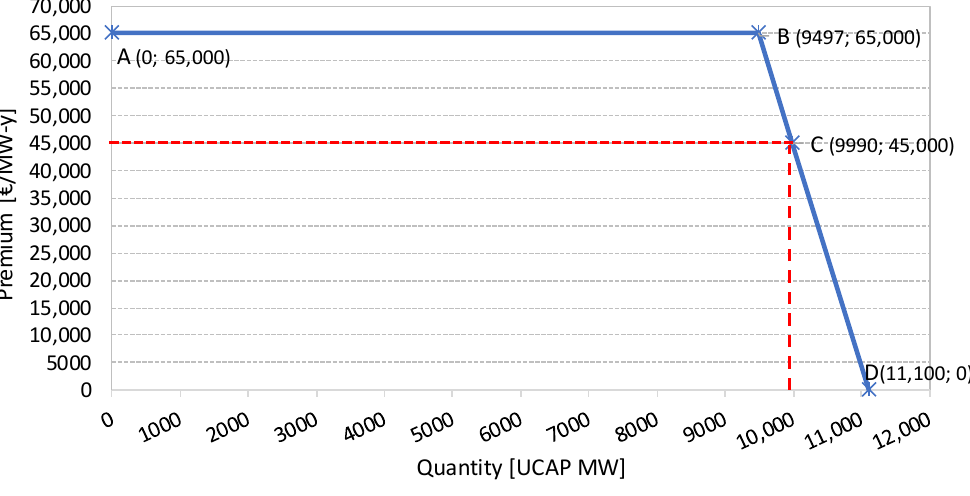
Figure 4. Auction demand curve/intermediate load scenario/Year 2025.